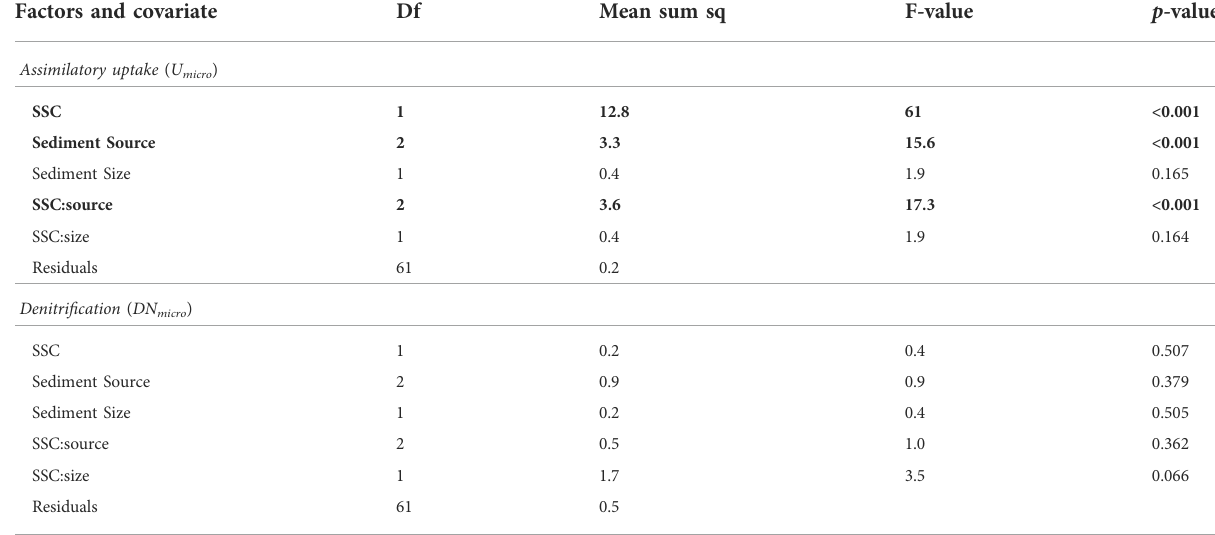
TABLE 2 Results of two separate ANCOVA models testing the effects of sediment source, size and suspended sediment concentration (SSC) on assimilatory uptake ( U micro ) and denitri fi cation ( DN micro ) rates, respectively. All data were log 10 -transformed prior to the analysis. Bold values indicate signi fi cant ANCOVA effects as stated in the table